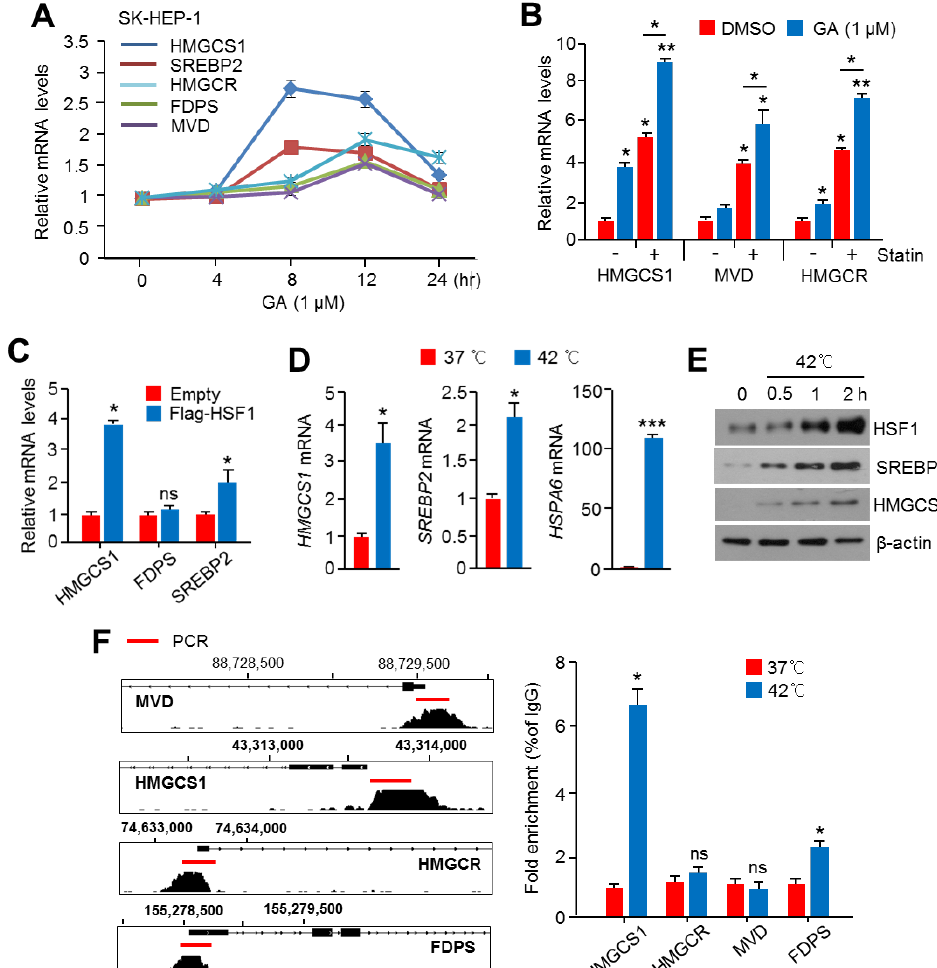
Figure 3. Heat Shock Factor 1 (HSF1) promoted the expression of mevalonate and cholesterol biosynthesis-related genes and proteins in HCC cells. ( A ) SK-HEP-1 cells were treated with geldanamycin (GA, 1 µ M) for 4, 8, 12, and 24 h, as indicated, and mRNA levels were measured using qRT-PCR. The values represent the mean ± SD of two independent experiments performed in triplicate. ( B ) SK-HEP-1 cells were pre-incubated with simvastatin (10 µ M) for 1 h, and then cells were further incubated with GA (1 µ M) for 10 h. The values represent the mean ± SD of two independent experiments performed in triplicate. ( C ) Flag-tagged HSF1 was ectopically overexpressed in SK-HEP-1 cells, and then cells were incubated for 24 h. The mRNA levels were measured using qRT-PCR. The values represent the mean ± SD of two independent experiments performed in triplicate. ( D , E ) SK-HEP-1 cells were incubated at 37 ◦ C or 42 ◦ C for 1 h, and then mRNA levels were measured using qRT-PCR. The values represent the mean ± SD of two independent experiments performed in triplicate, and the protein expression was measured by western blotting. ( F ) ChIP-seq profiles of sterol regulatory element-binding protein 2 (SREBP2) enrichment indicating transcriptionally active regions of 3-Hydroxy-3-Methylglutaryl-CoA Synthase 1 (HMGCS1), 3-Hydroxy-3-Methylglutaryl-CoA Reductase (HMGCR), farnesyl diphosphate synthase (FDPS), and mevalonate diphosphate decarboxylase (MVD). Representative images obtained by ChIP-Atlas (https: // chip-atlas.org / ) and integrative genomic viewer (IGV, https: // software.broadinstitute.org / software / igv / ). SK-HEP-1 cells were incubated at 37 ◦ C or 42 ◦ C for 1 h and then lysed, and sonicated cell lysates were immunoprecipitated with anti-HSF1 for 16 h at 4 ◦ C. Immunoprecipitated complexes were washed and pulled-down DNA fragments obtained. HSF1 enrichment was measured by qPCR, and fold enrichment was normalized to normal serum (IgG) control. The values represent the mean ± SD of three independent experiments performed in duplicate. * p < 0.05; ** p < 0.01; ns, not